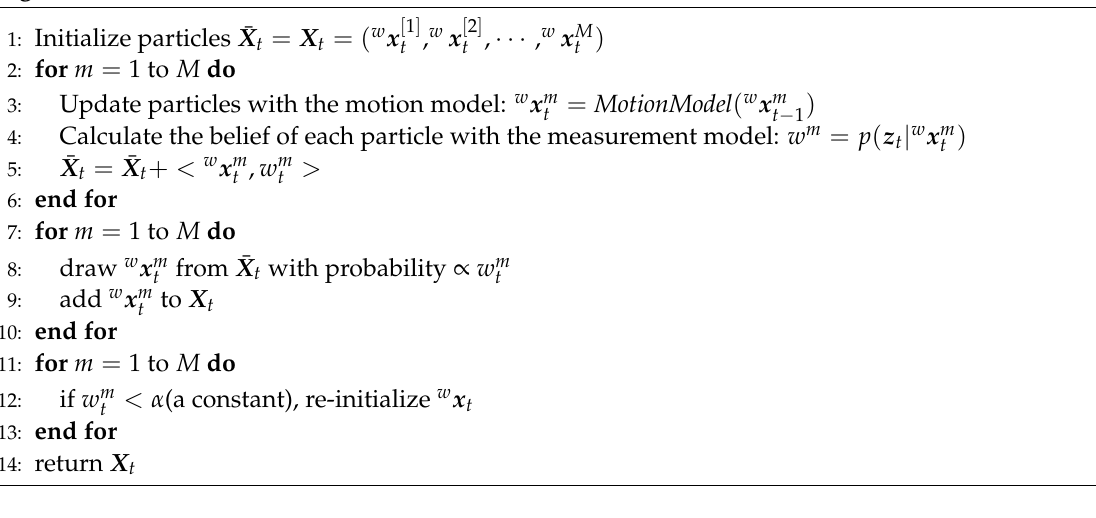
Algorithm 1 Monte Carlo localization.